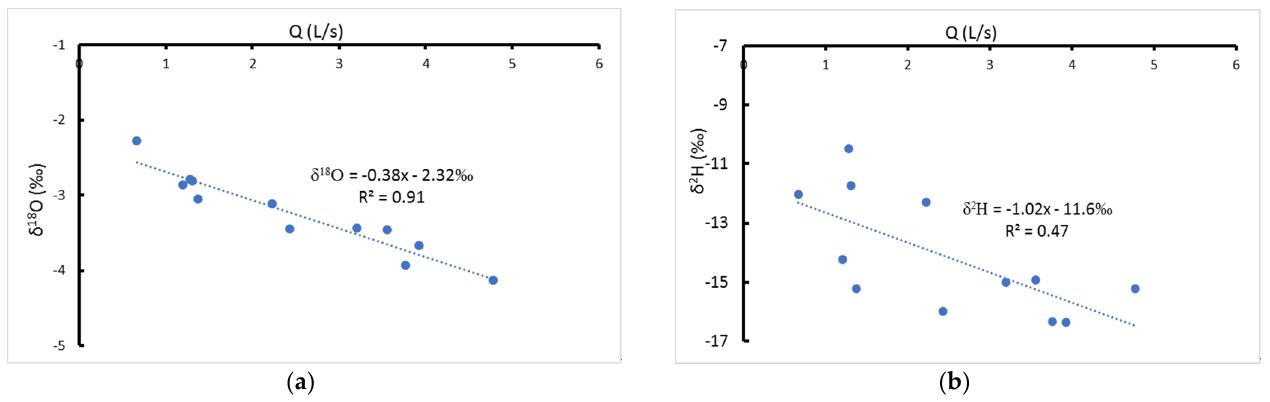
Figure 6. Plots of Albert Farm spring yield versus ( a ) δ 18 O with a correlation of 0.51 and ( b ) δ 2 H with a very poor correlation 0.087.